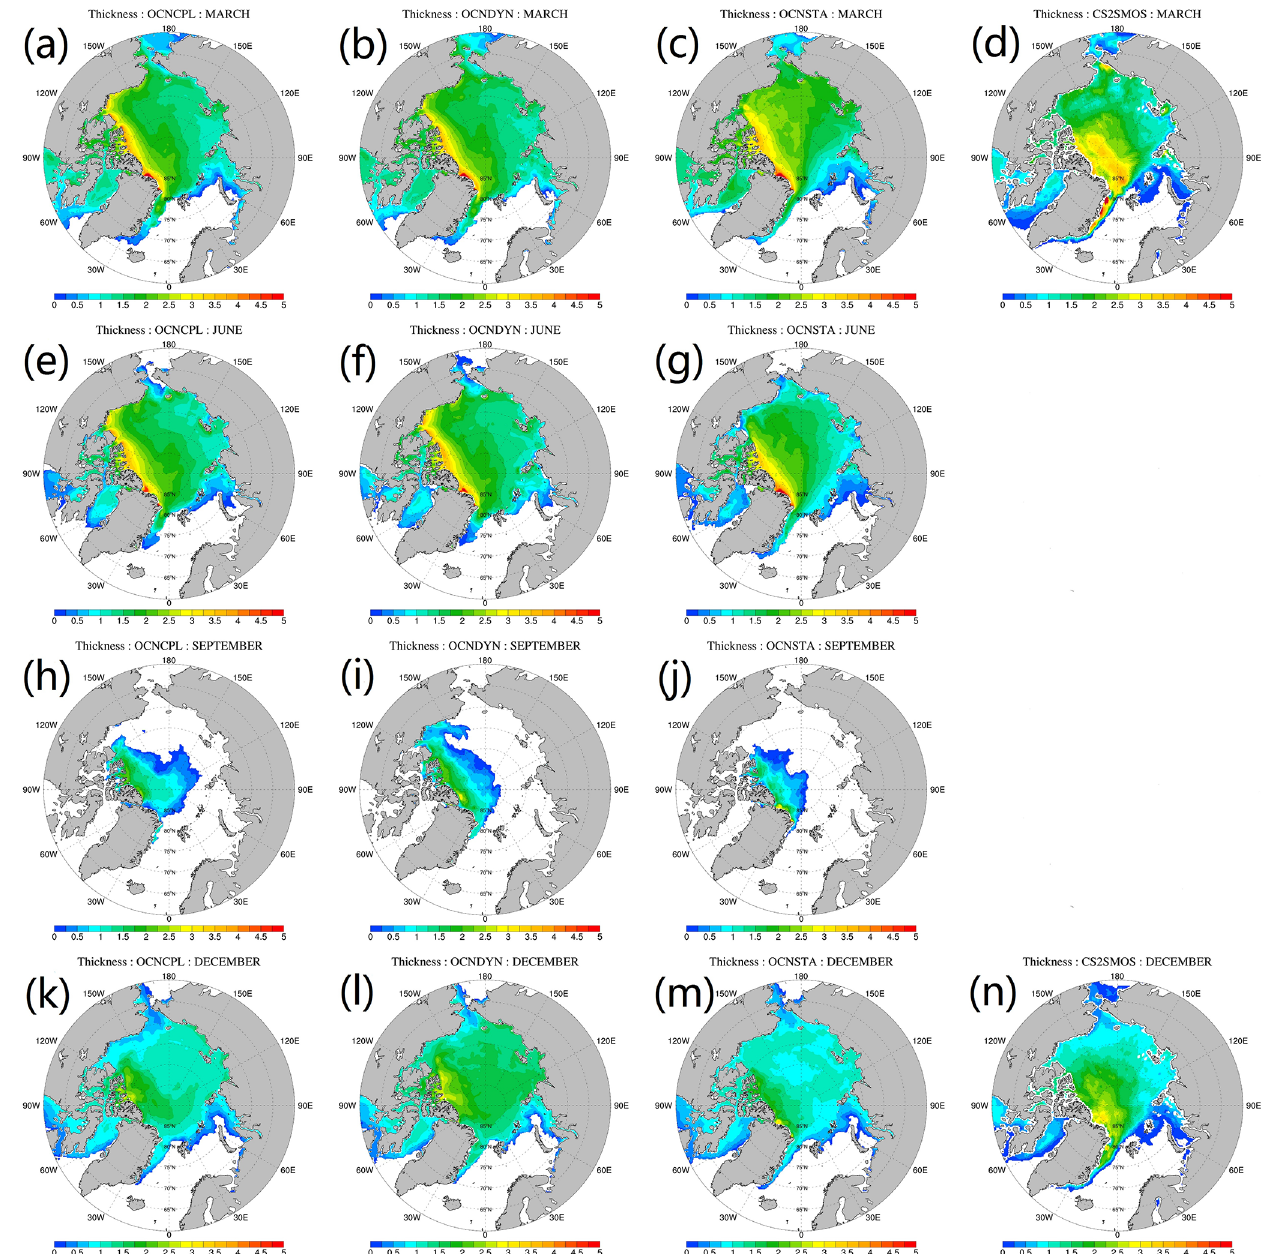
Figure 11. Monthly mean sea ice thickness. From top to bottom panels show the March, June, September and December sea ice thickness, respectively. From left to right panels show sea ice thickness of the OCNCPL run, the OCNDYN run, the OCNSTA run and the CS2SMOS